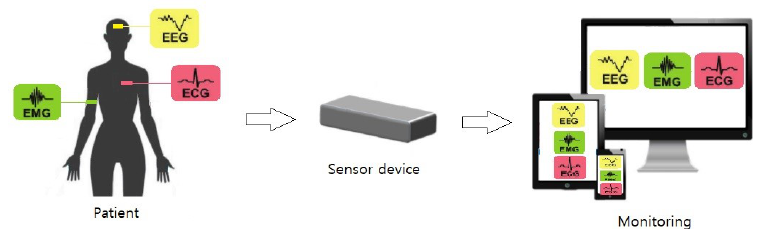
Figure 3. General setup of biosignal monitoring